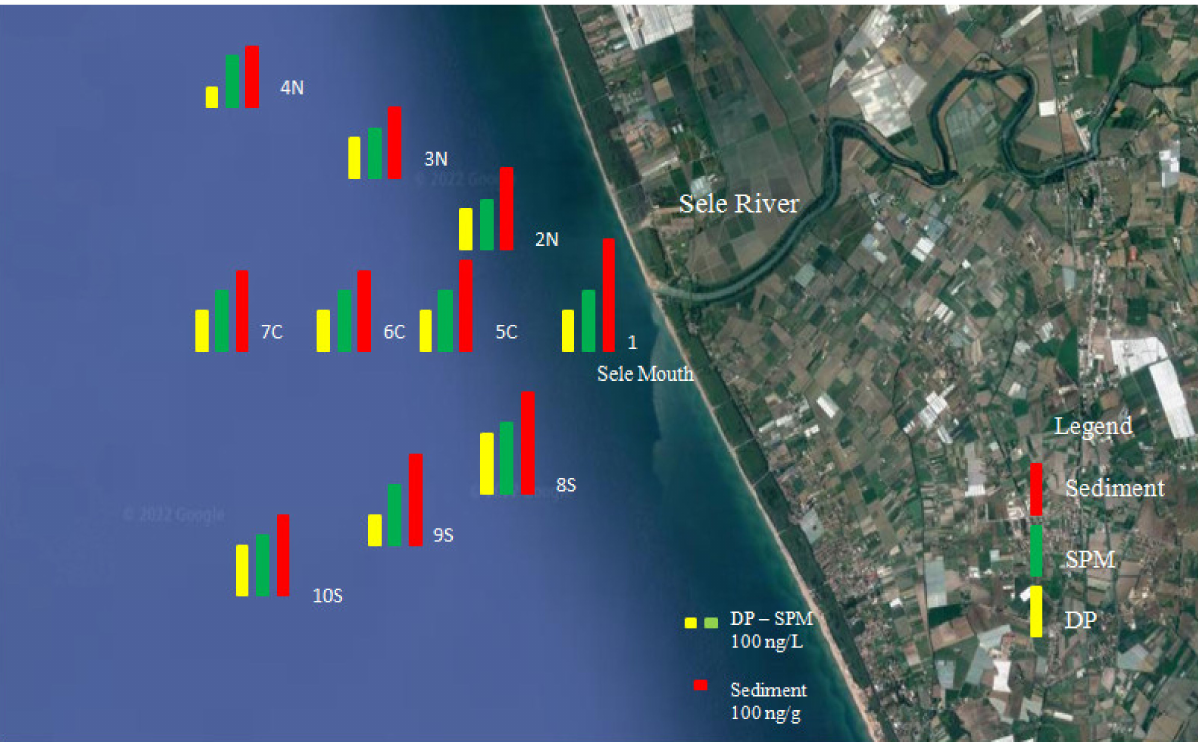
Figure 2. Spatial and temporal distributions of PAHs in the water-dissolved phase (DP, ng L − 1 ), suspended particulate matter (SPM, ng L − 1 ), and sediment (ng g − 1 dry wt) of the Sele River and estuary, southern